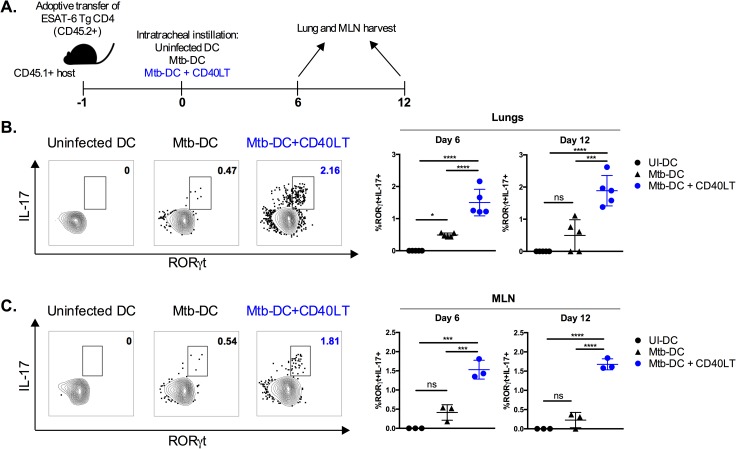
CD40 engagement of Mtb-infected DCs induces antigen-specific Th17
in vivo.(A) Diagram of experimental design. CD45.2+ ESAT-6 TCR Tg CD4 T cells were purified from spleen and lymph nodes and intravenously transferred (1x106 per mouse) into congenic (CD45.1+) hosts. Animals were rested for 1 day after which DCs (1x106 per condition) were transferred into recipient hosts by intratracheal instillation: uninfected DCs (UI-DC), Mtb-infected DCs (Mtb-DC) or Mtb-infected DCs with CD40L trimer treatment (Mtb-DC + CD40LT). Lungs and MLN were harvested 6 and 12 days post-intratracheal instillation and CD4 T cell responses assessed. MLN were pooled to attain sufficient cells for restimulation. Representative flow plots (left; day 6 values) and summary graph (right) of the lung (B) and pooled MLN (C) frequencies of RORγt+IL-17+ cells after ESAT-61−20 restimulation 6 and 12 days after DC transfer. Populations shown have been pre-gated on live CD3+CD8-γδ TCR-CD45.2+ singlets. 5 mice were used for each group. Statistical significance was determined using one-way analysis of variance (ANOVA) correcting for multiple comparisons. * p<0.05, *** p<0.0005, **** p<0.0001, ns = not significant.